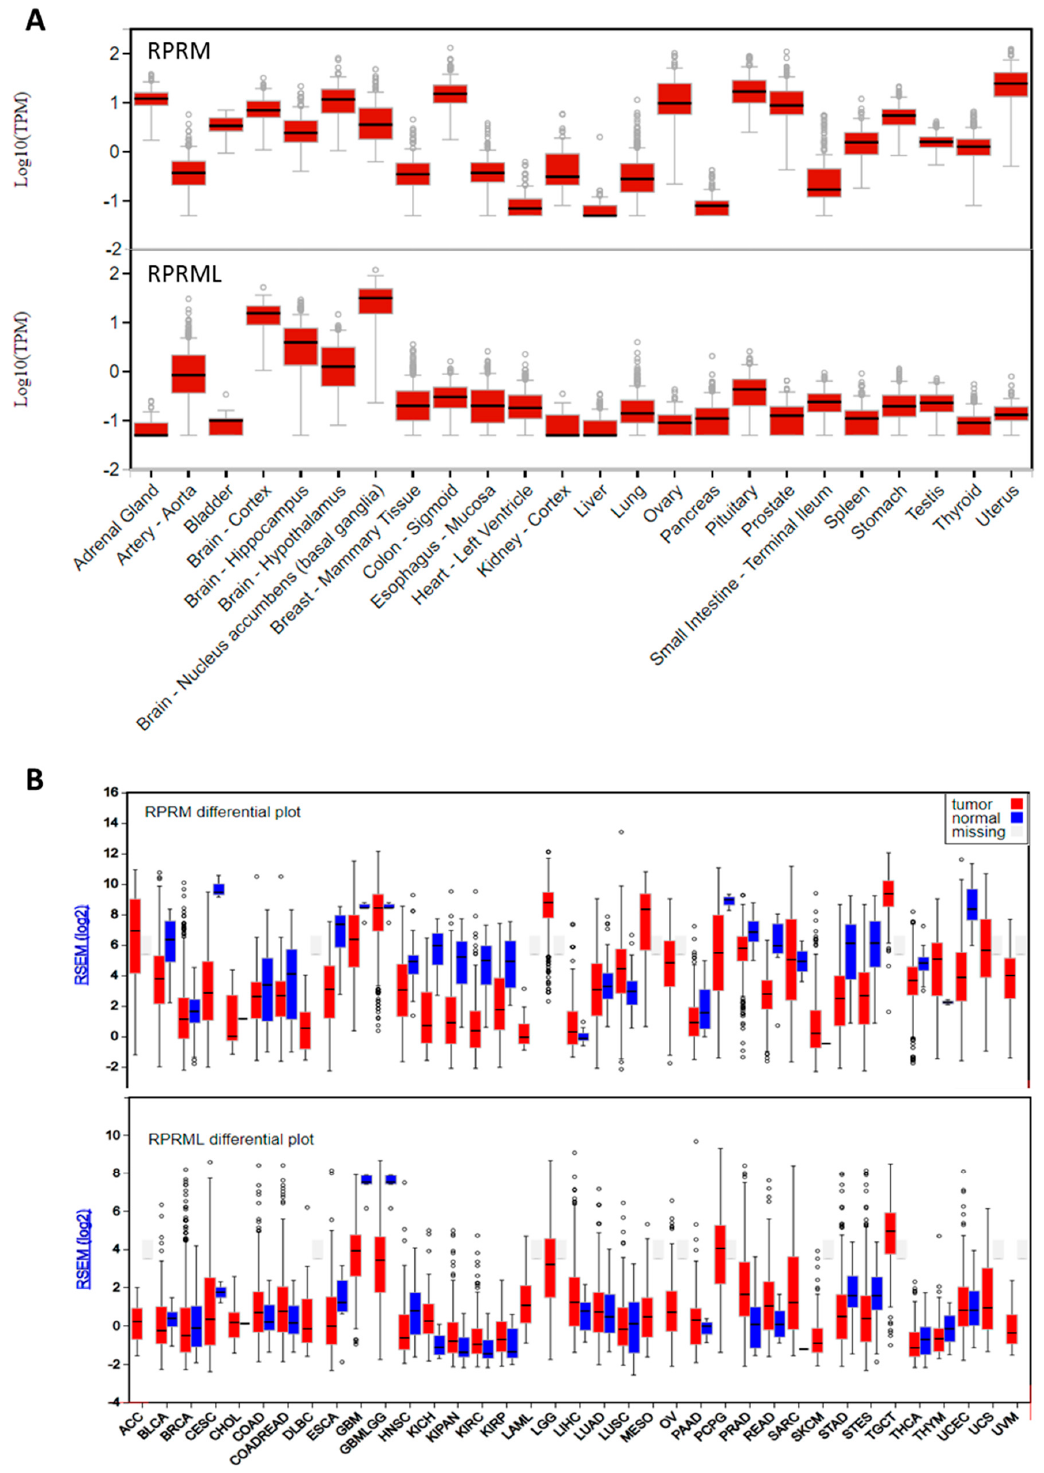
Figure 3. RNA expression of RPRM and RPRML across different tissues. ( A ) Tissue-specific expression profile from 570 human donors available in the Genotype-Tissue Expression (GTEx) database [28]. Data is expressed as log10 of Transcripts Per Kilobase Million (TPM). ( B ) Expression levels of human tumor and matched normal tissue samples from Broad Institute TCGA Genome Data Analysis Center [0]. Data is expressed as log2 of RSEM (RNA-Seq by Expectation Maximization).